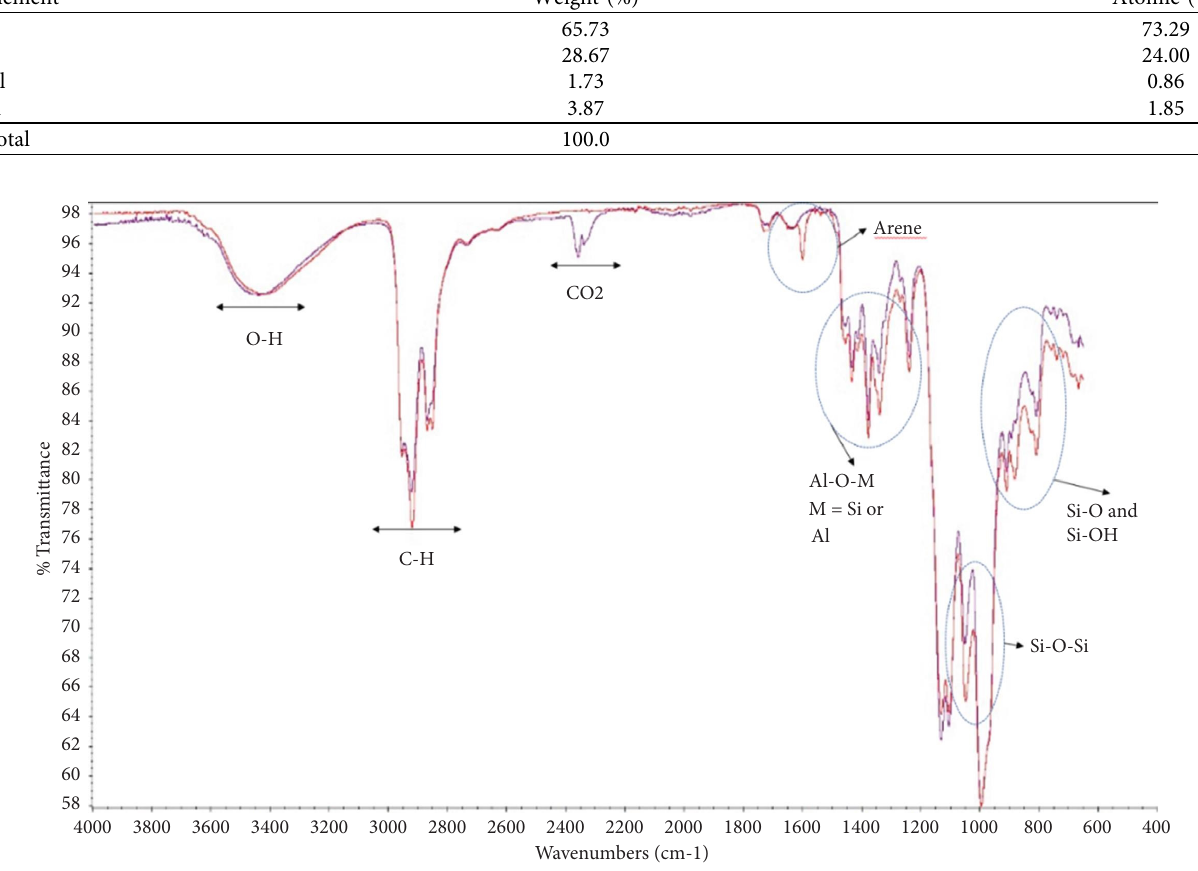
Figure 4: FTIR of PVB/bentonite